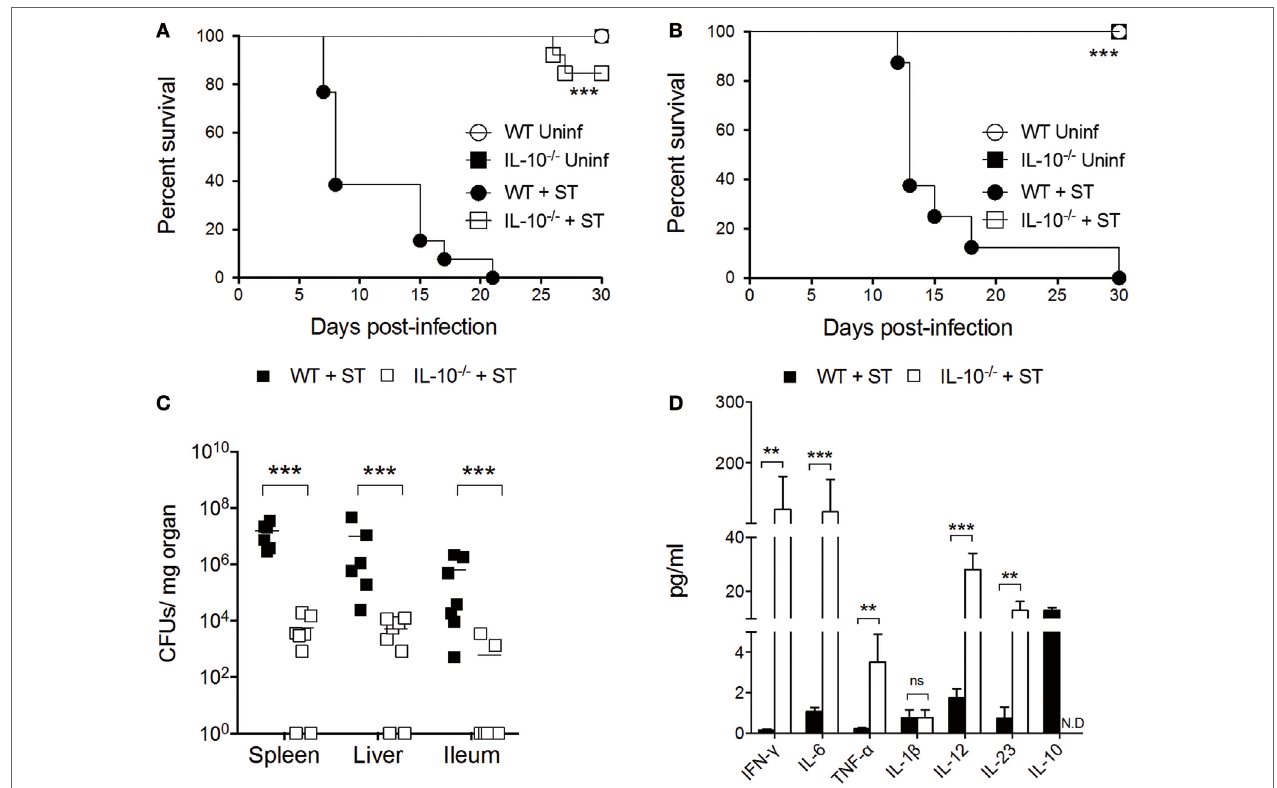
FigUre 1 | Absence of interleukin-10 (IL-10) production improves host survival and prevents systemic dissemination of S. Typhimurium. Wild-type (WT) C57BL/6 and IL-10 − / − mice were infected (a) orally and (B) intraperitoneally with S . Typhimurium (ST) and survival rate were followed for 30 days. (c) Bacterial burden in spleen, liver, and ileum and (D) cytokine production in serum were evaluated in orally infected WT and IL-10 − / − mice at 5 days post infection. For survival assays, *** P < 0.001 log-rank test. For colony forming units (CFUs) loads and cytokine quantification, a student’s t -test was performed between WT- and ST-infected mice; ** P < 0.01; *** P <